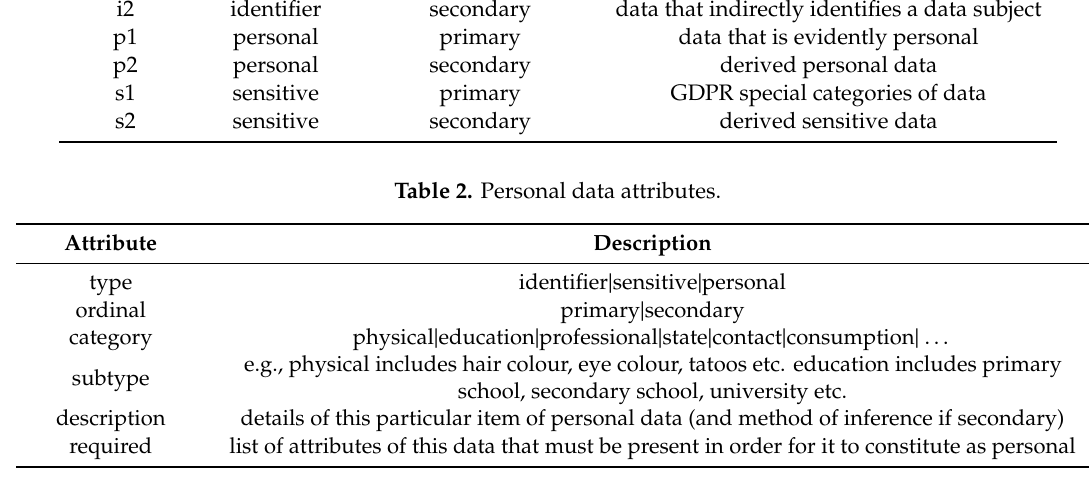
Table 2. Personal data attributes.